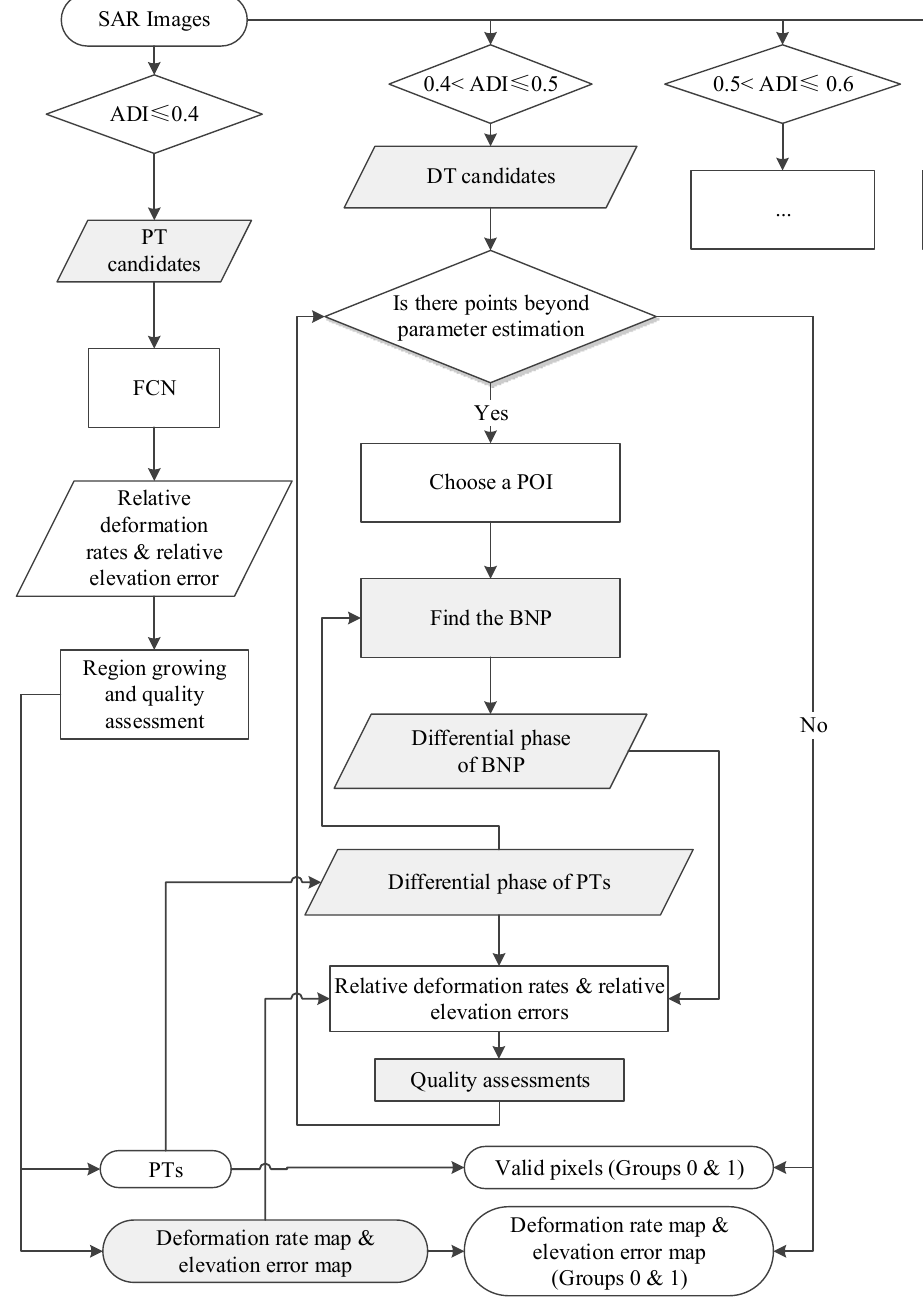
Figure 2. Flow chart of hierarchical processing. ADI, amplitude dispersion index; DT, distributed target; PT, point-like target; FCN, freely connected network; POI, pixel of interest; BNP, best neighboring